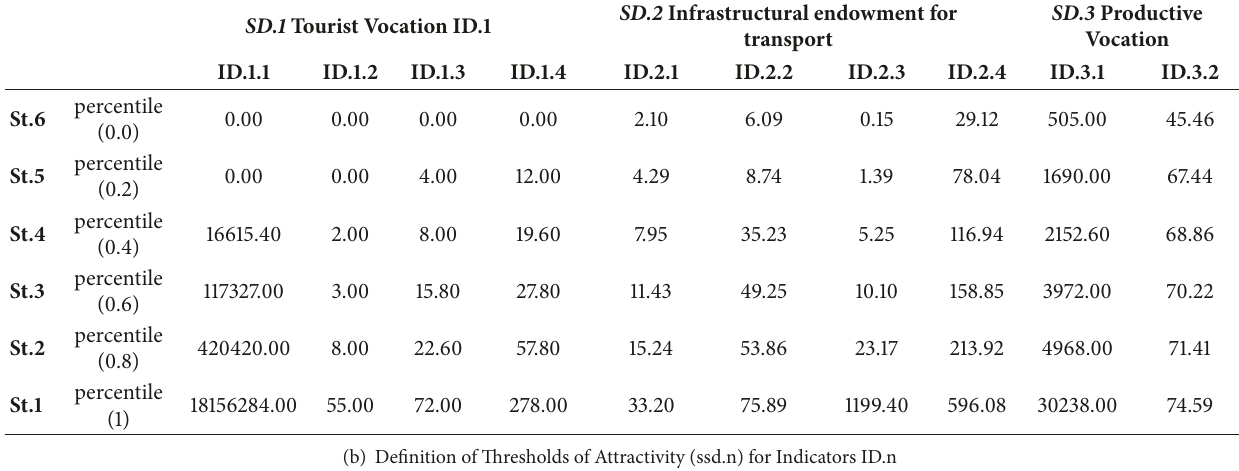
Table 10: MCSDA implementation for JLD: statistical analysis for the definition of Thresholds of Attractiveness (a) and definition of the Thresholds of Attractiveness for each Indicator